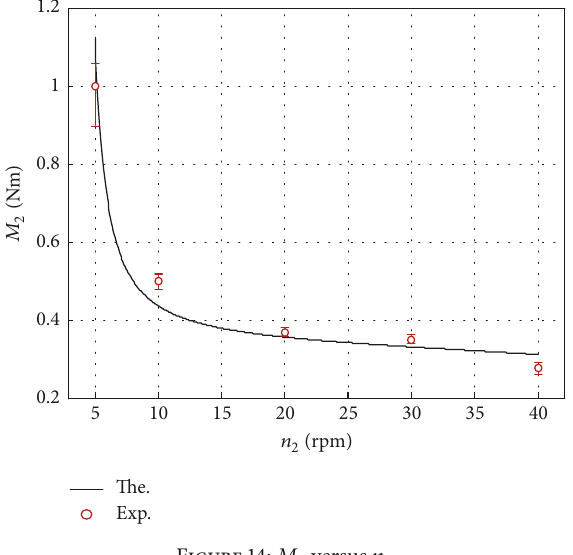
Figure 14: 𝑀 2 versus 𝑛 2